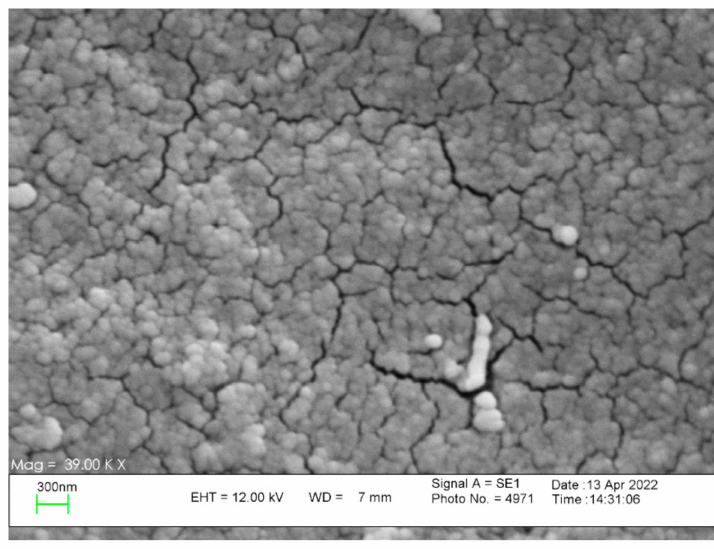
Figure 4. SEM results of POM@CSIm